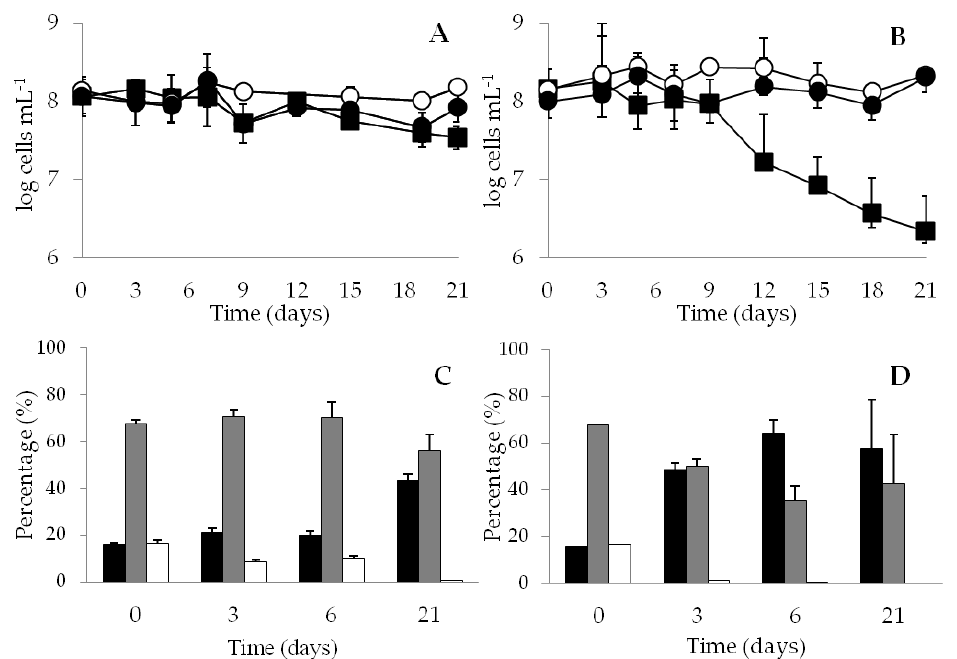
Figure 1. V. harveyi ATCC 14126 T survival in seawater (starvation) at 20 °C in dark ( A , C ) or in the presence of illumination ( B , D ). A and B, variations of total ( ○ ), viable ( ● ) and culturable bacteria in Marine Agar ( ■ ) obtained during 21 days. C and D, variations in cell size distribution ( █ ≤ 0.91 μ m; █ > 0.91 - ≤ 1.74 μ m ; █ > 1.74 μ m ) . The data are mean values from three independent experiments with errors bars representing the standard deviations calculated.